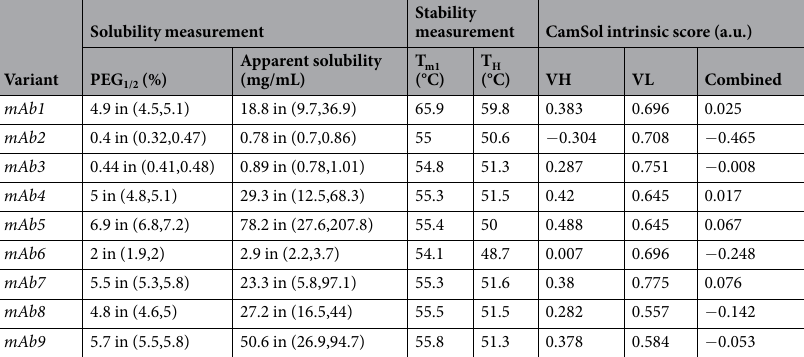
Stability measurement CamSol intrinsic score (a.u.)